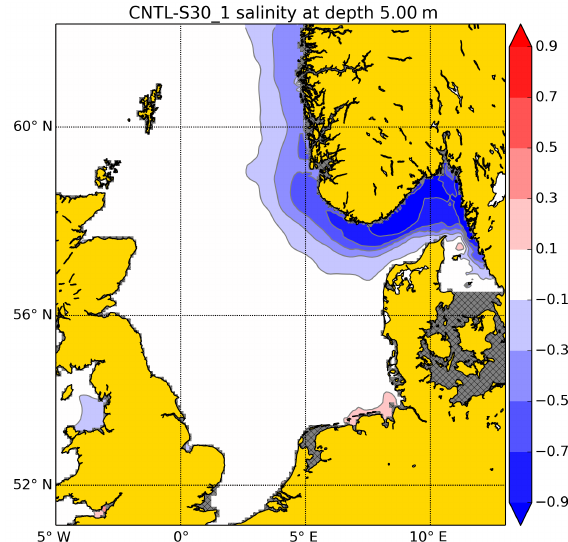
Figure 12. Comparison of mean salinity at 5m between CO5 with 51 vertical levels using the Siddorn and Furner stretching func- tion (CNTL) and 33 vertical levels using the Song and Haidvogel stretching function (S30_1). The hashed area in the Kattegat indi- cates the interface to Baltic NSBS model data.